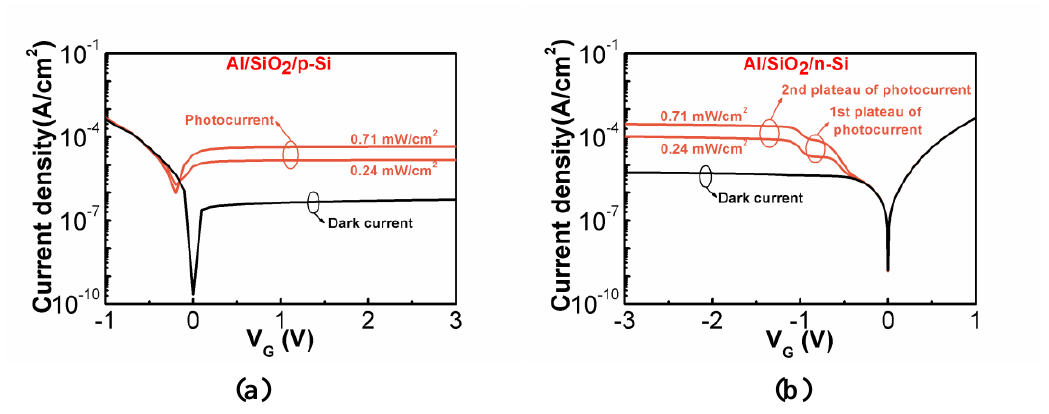
Figure 12. Dark current and photocurrents of the (a) Al/SiO (b) Al/SiO /n-Si MIS (PMOS) diode. The inversion biases were positive and negative 2 voltages for NMOS and PMOS photodetectors, respectively